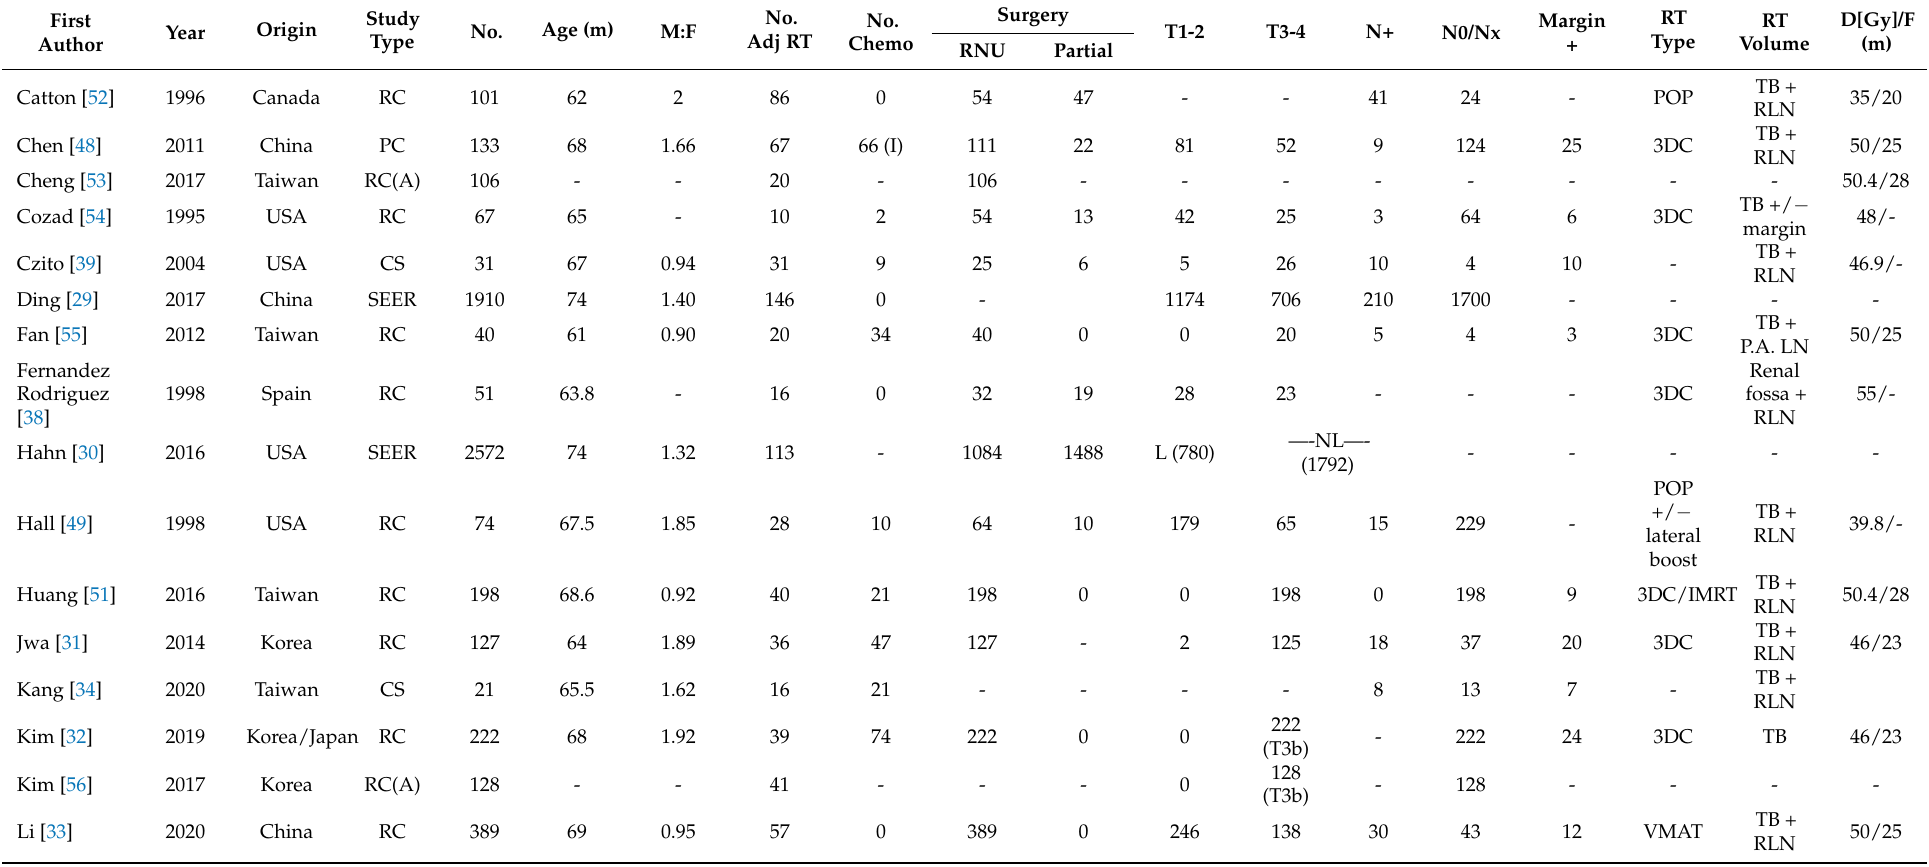
Table 2. Baseline